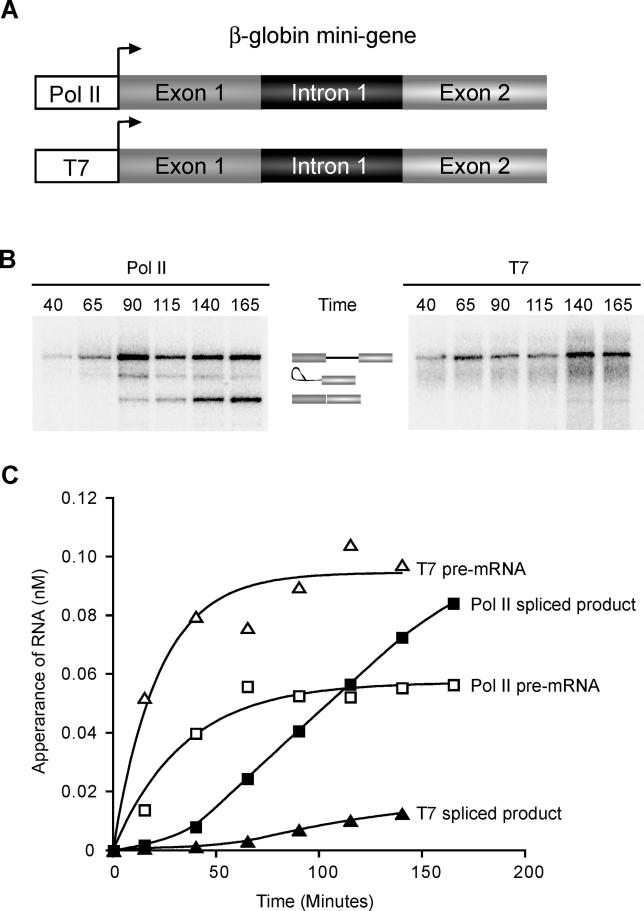
Linking Splicing to Pol II Transcription Increases the Efficiency of Pre-mRNA Splicing(A) Diagrams of the two templates used in the transcription/splicing assay, both contain the first exons of the
β-globin gene. The template on the left is headed by the AdML Pol II promoter while the right template is headed by the T7 promoter. (B) Representative autoradiograms of the in vitro transcription/splicing assay appear below the diagrams. Pre-mRNA transcripts were either synthesized by Pol II (left) or T7 polymerase (right). Pre-mRNA transcript, spliced product, and intermediate lariat bands are indicated. (C) Quantitation of the data in (B). Molar concentration of RNA was determined by normalizing counts per min to a known concentration of radiolabeled RNA.